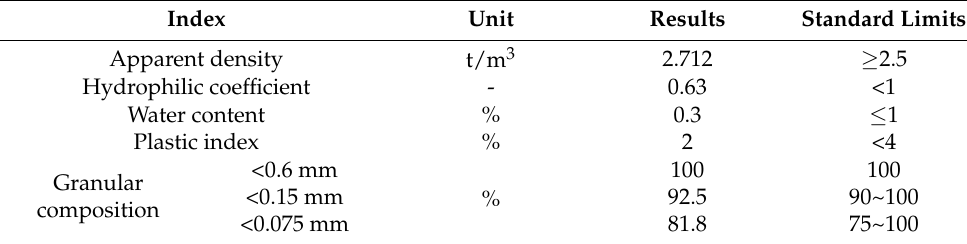
Table 4. Basic physical parameters of mineral